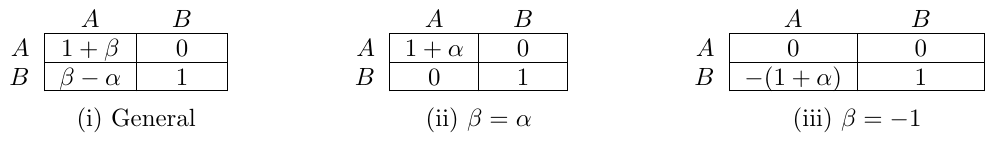
Figure 3. Two player prisoner’s dilemma. Let β , γ > 0. For each combination of C and D , entries give payoffs for the row player. β is the payoff advantage of ( C , C ) over ( D , D ) . γ is the gain from defecting on a cooperator. The gain from defecting on a defector is normalized to 1.